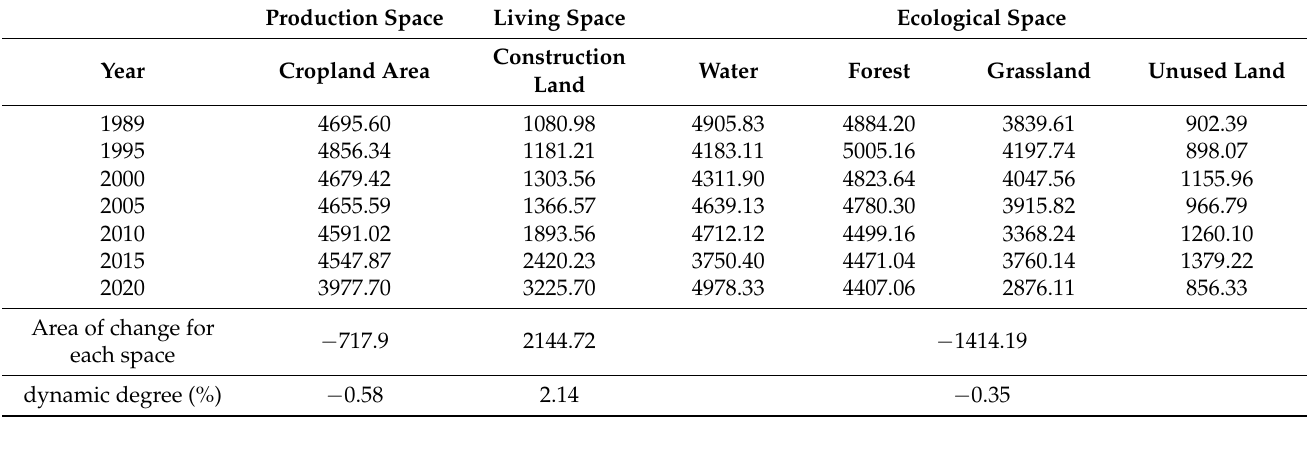
Table 4. Change in the PLE area in the PYL area from 1989 to 2020 (km 2 ).